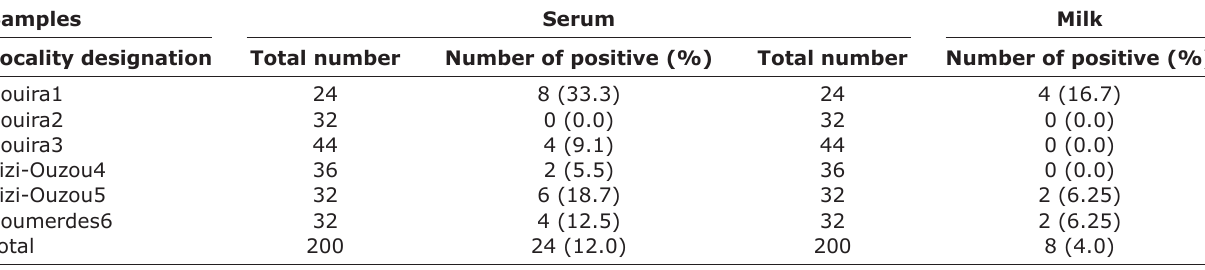
Table - 1: Occurrence of Helicobacter pylori among cows’ serum and milk samples using ELISA.